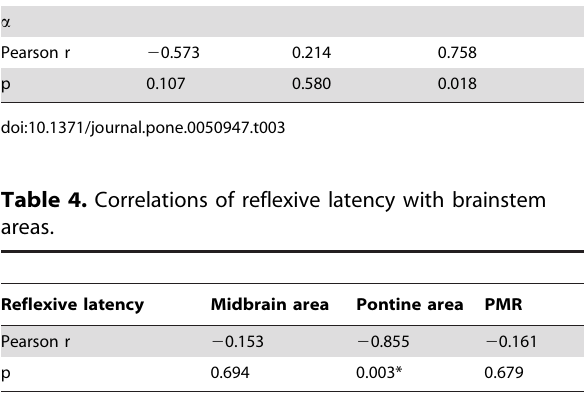
Figure 1. Comparisons of saccadic parameters between NPC patients and controls (error bars + / 2 1 S.D.) for a) horizontal saccade a , b) horizontal asymptotic peak velocity Vmax, c) gain, d) latency, e) self-paced saccade rate over 30 s and f) percentage of